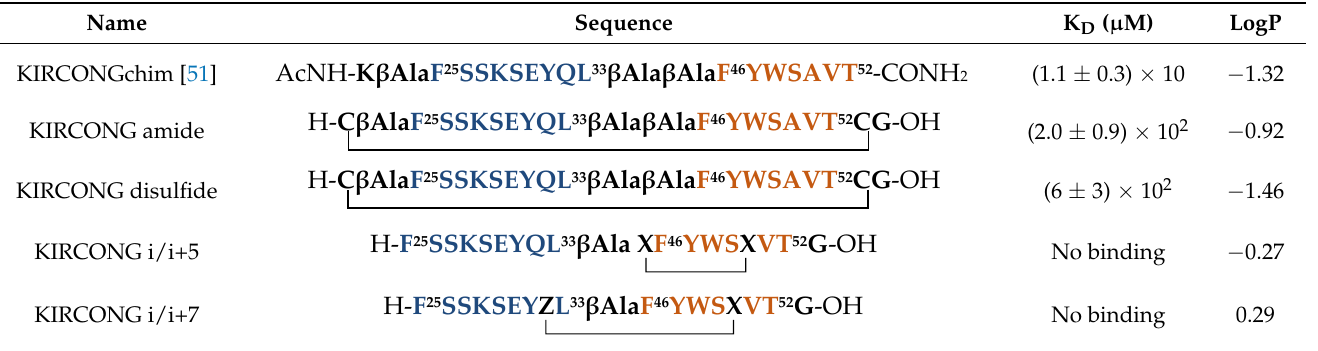
Table 1. Sequences and names of compounds investigated in this study. Residues belonging to different human SOCS3 regions are colored in blue (KIR) and orange (CONG). X: (S)-2-(4 ′ -pentenyl) alanine Z: (R)-2-(7 ′ -octenyl) alanine).